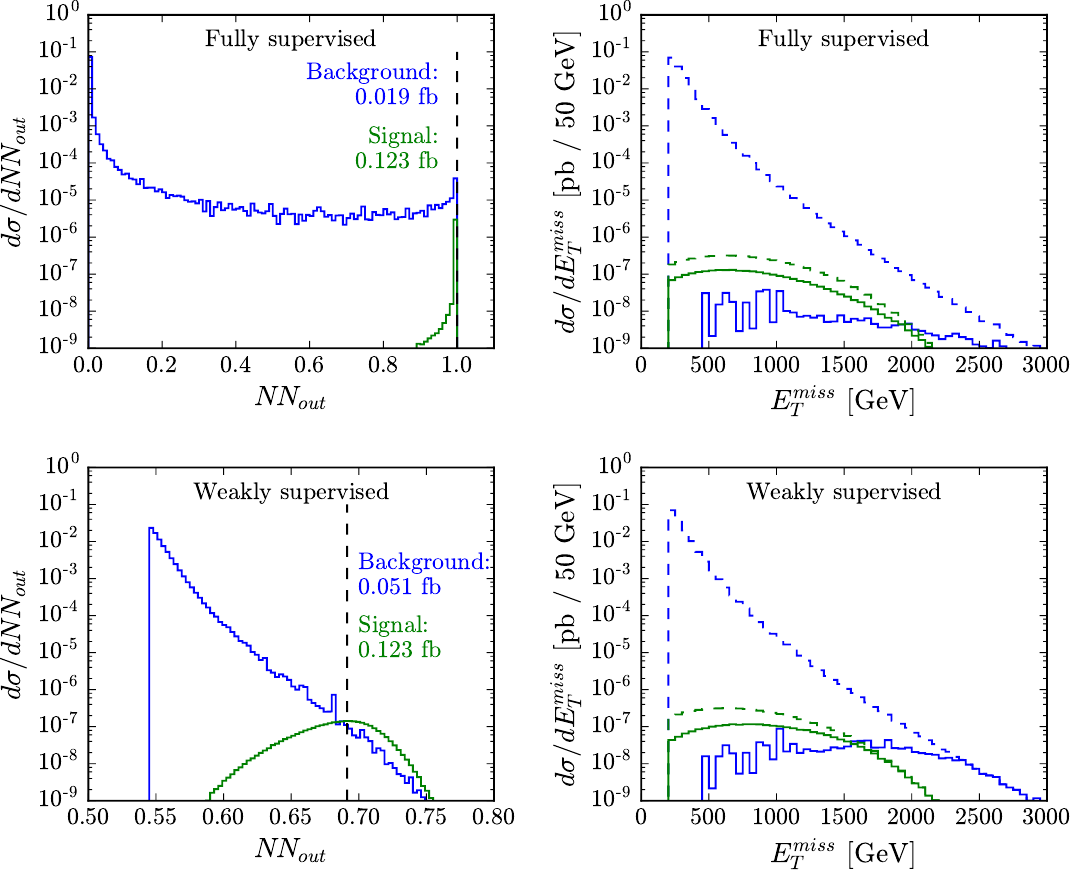
Figure 9 . The left panels show the di(cid:11)erential cross section as a function of the neural network outputs for the fully and weakly supervised networks on the top and bottom, respectively. The dashed vertical lines show where the cut is placed, while the labels mark the signal and background cross sections passing the cut. The cut was chosen such that both networks yield the same number of signal events. Note that the top left plot confusingly never shows S=B > 1 due to a (cid:12)nite bin size artifact. The right panels show the e(cid:11)ect of the cut on the missing energy spectrum. The dashed (solid) lines show the distributions before (after) the cut is made. Both of the neural networks are able to reject the dominant background at low values of missing energy, while keeping most of the similar signal